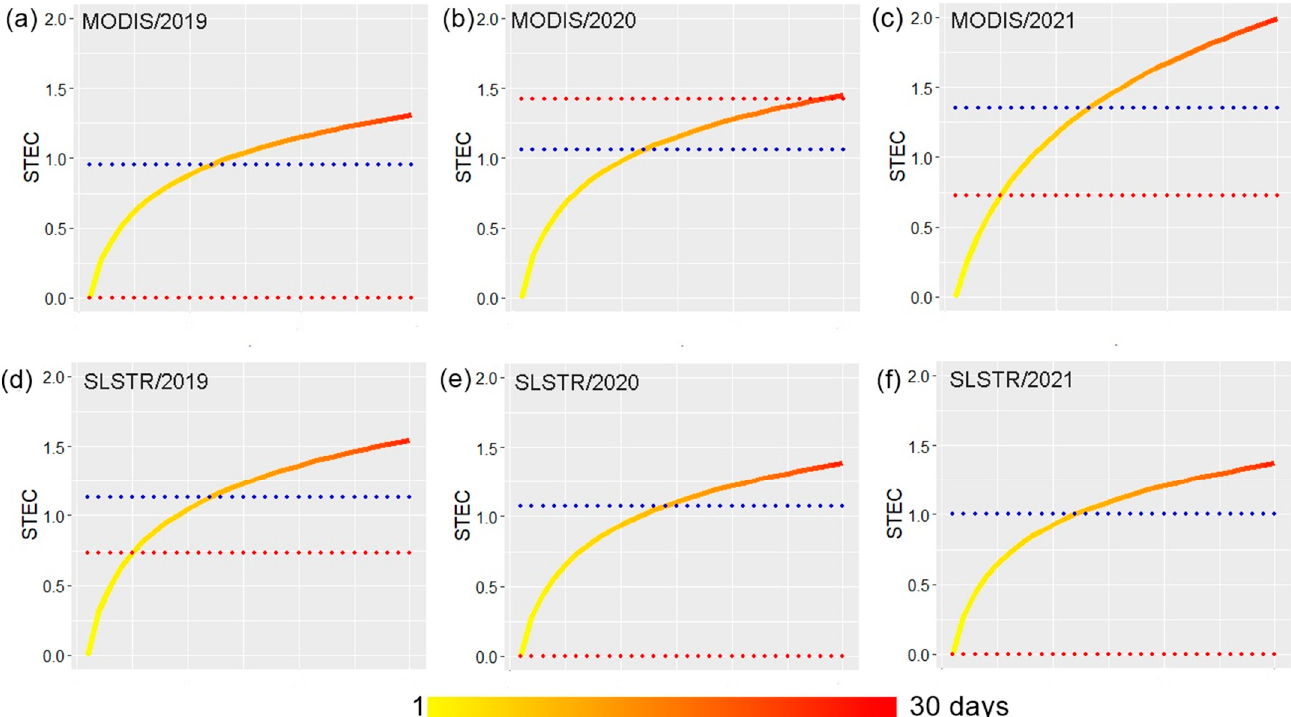
Figure 7. Detection of SLSTR and MODIS burned areas through the daily and average 30-day STEC coefficient. Red dashed line represents the sensor and the blue dashed line the average 30-day STEC coefficient. ( a ) and ( d ) for 2019, ( b ) and ( e ) for 2020, and ( c ) and ( f ) for 2021.